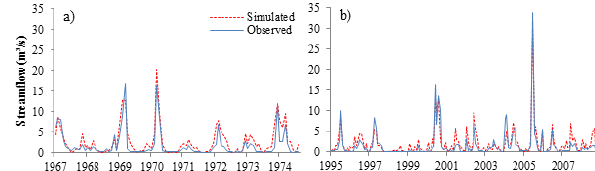
Figure 2. Simulated versus observed monthly streamflow in the